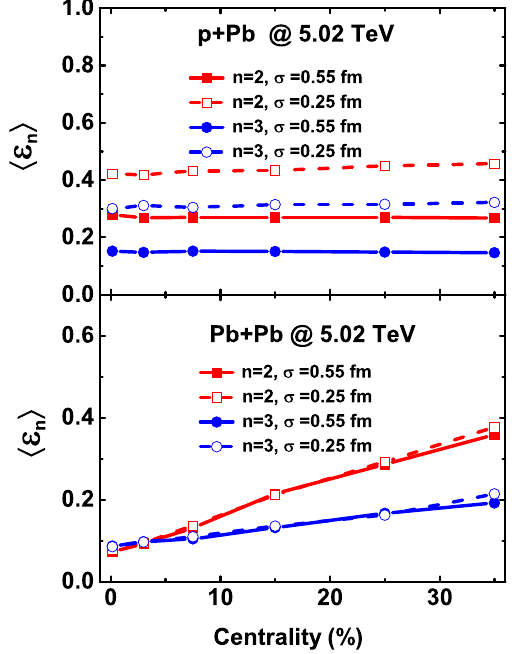
Fig. 7 (cid:2) (cid:12) 2 (cid:3) and (cid:2) (cid:12) 3 (cid:3) as a function of centrality in p + Pb and Pb + Pb collisions for two cases: σ = 0 . 55 fm and σ = 0 . 25